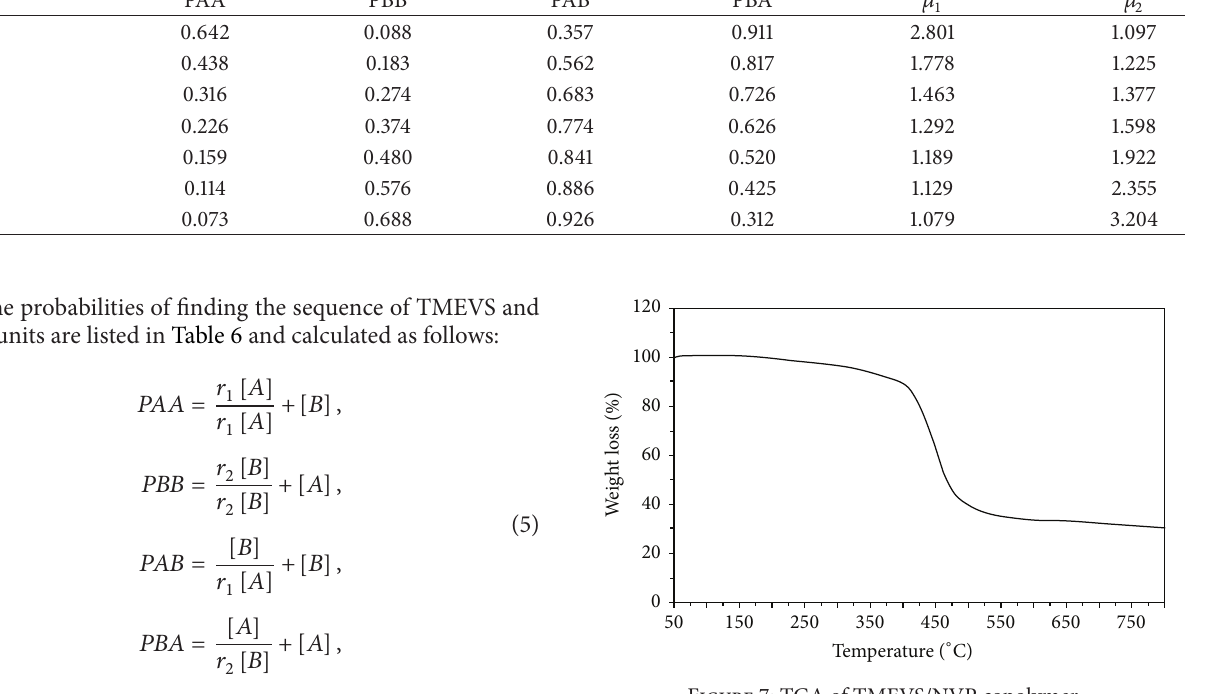
Figure 7: TGA of TMEVS/NVP copolymer.